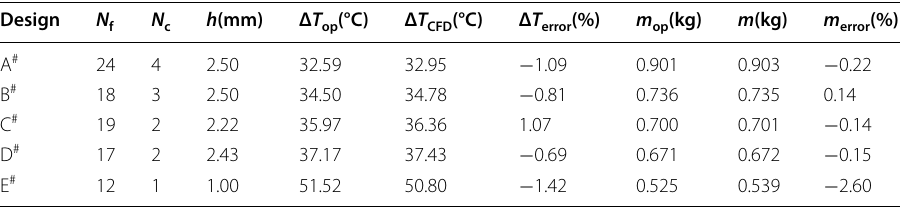
Table 5 Validation of the optimization results